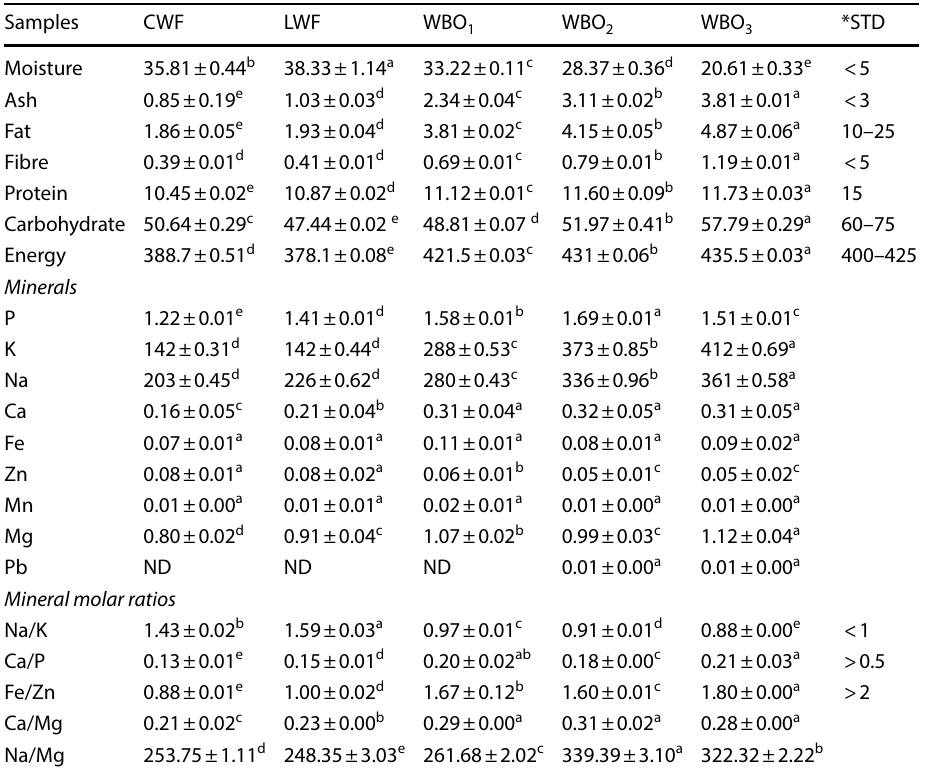
Means ( ± SD) with different alphabetical superscripts in the same row are significantly different at P < 0.05. *CODEX CAC/GL 08 [85]. [75% wheat, and 25% bambara groundnut (WBO bara groundnut (WBO ); 25% wheat, and 75% bambara groundnut (WBO 2 (CWF) and Laboratory wheat